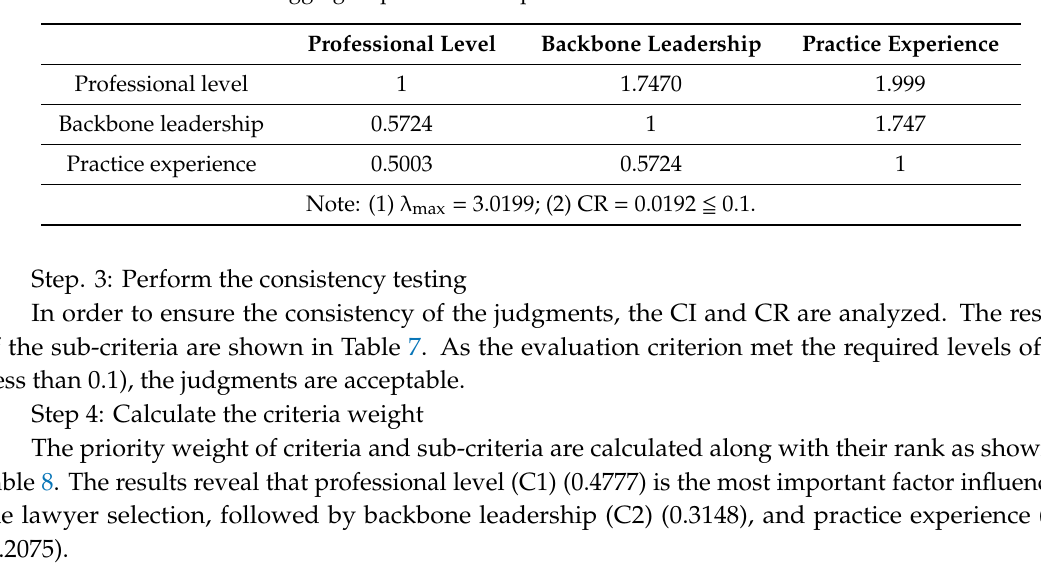
Table 8. Weights of criteria and sub-criteria.